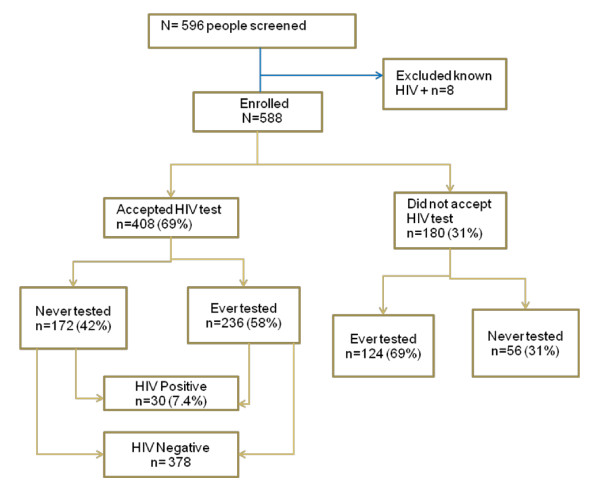
Study Flow Chart.